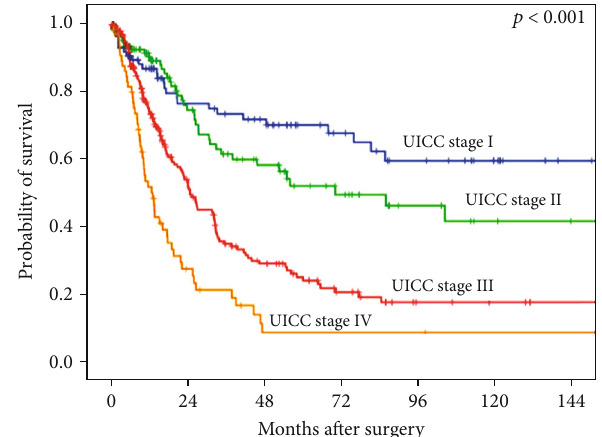
Figure 1: UICC stage adjusted survival for the entire patient cohort ( n = 551